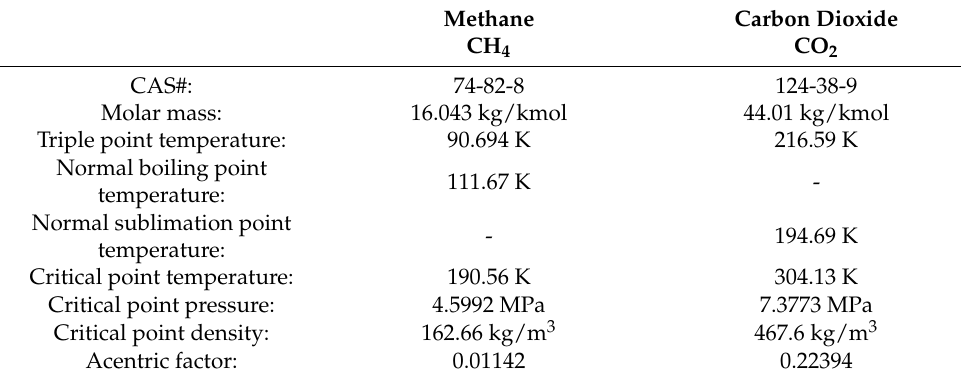
Table 2. Characteristic points of the phase diagrams of methane [5,6] and carbon dioxide [5,9].